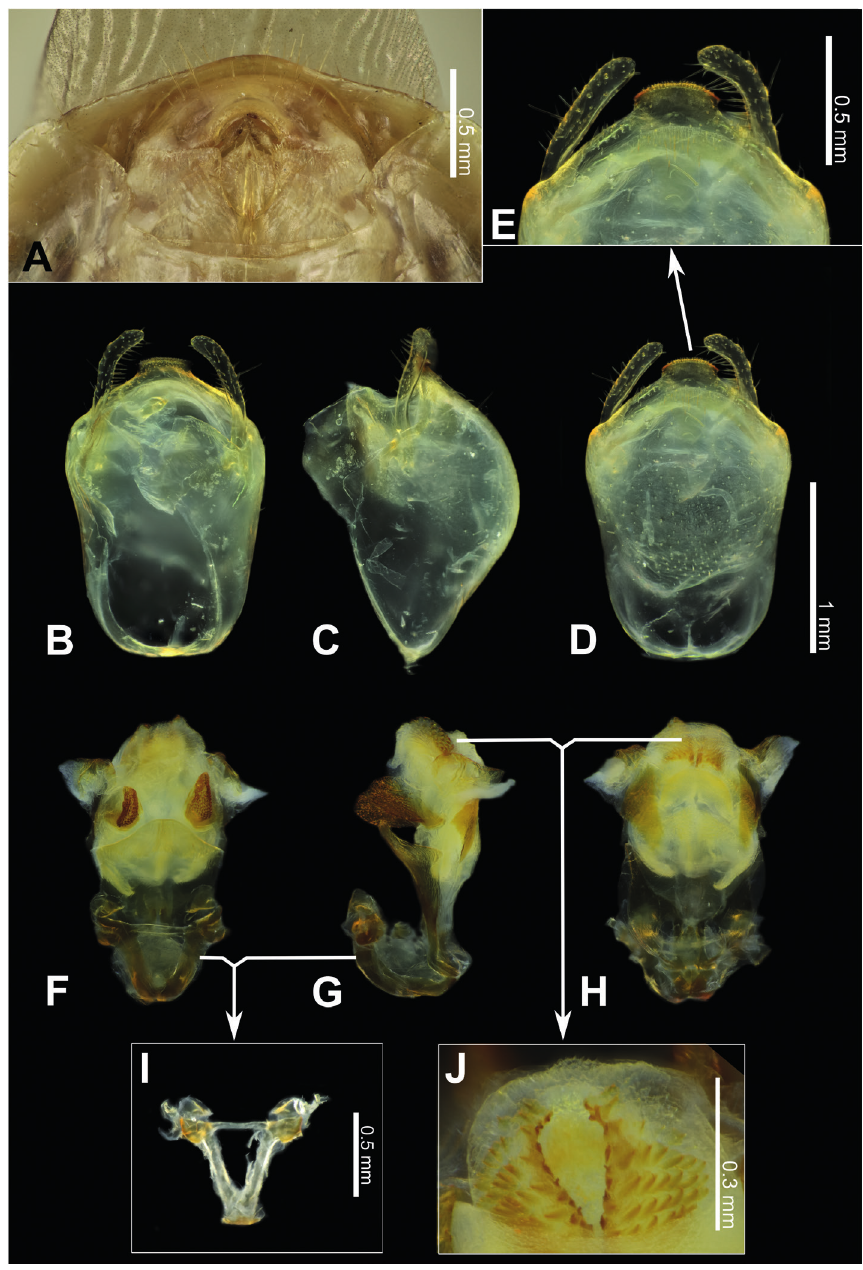
Figure 21. Biasticus luteicollis Ha, Truong & Ishikawa, sp. nov. A female external genitalia in ventral view, paratype, ♀ , HNL2018-024 B–J male genitalia, holoype, ♂ , HNL2018-025 B–E pygophore with parameres B dorsal view C lateral view D ventral view E apical portion of pygophore, showing median process (mpp) and parameres F–H phallus F phallus with endosoma semi-everted, dorsal view G phallus with endosoma semi-everted, lateral view H phallus with endosoma semi-everted, ventral view I articula- tory apparatus (aa) J distal dorsal lobe of endosoma